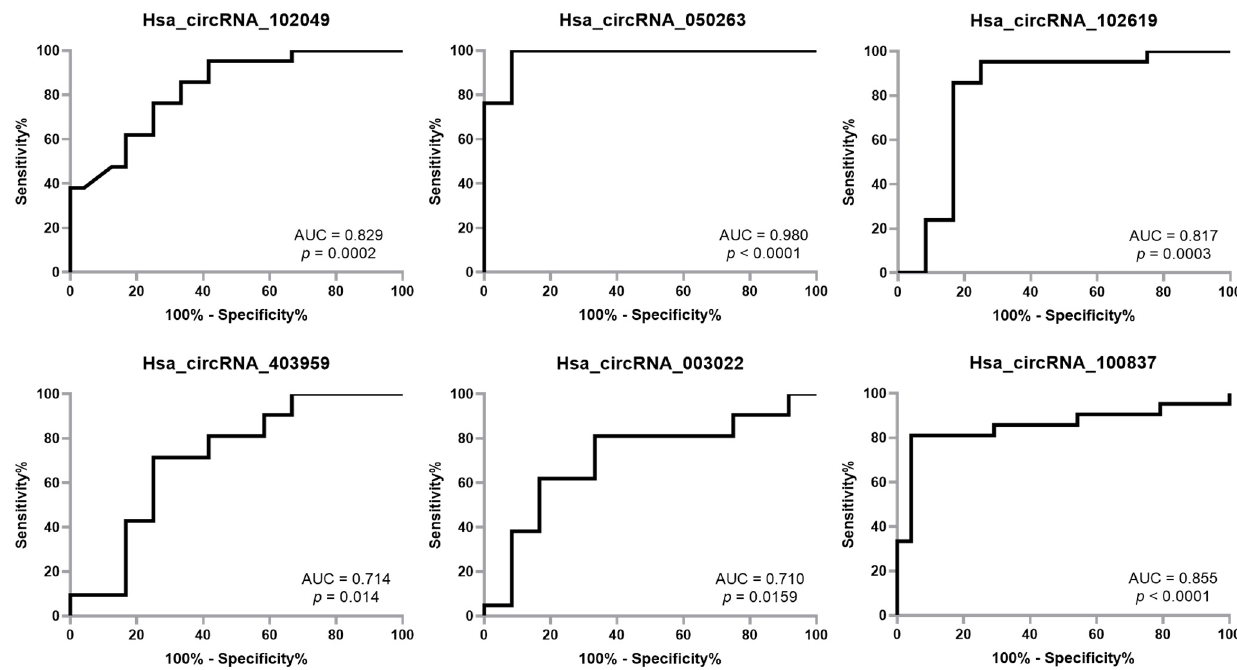
Figure 4. Receiver operating characteristic (ROC) curve of differentially expressed circRNAs in AD vs HC. AUC: Area Under the Curve .